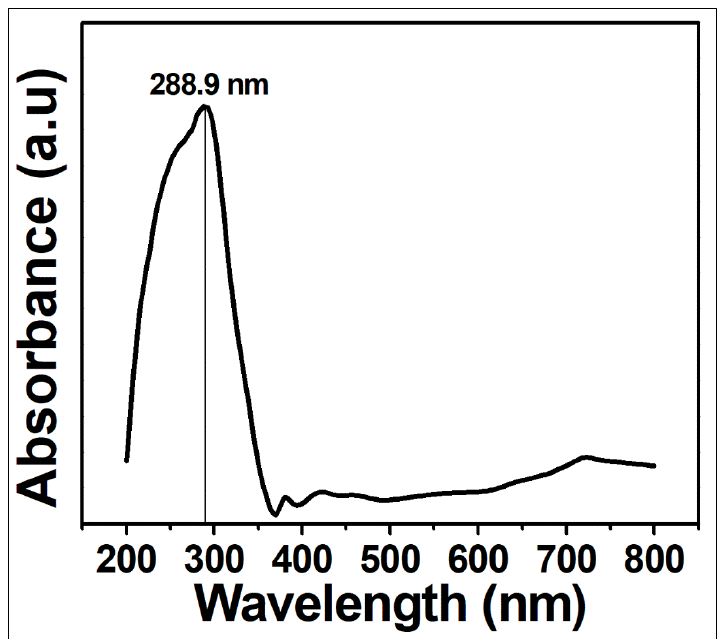
Figure 5. UV ‐ visible spectrum of biosynthesized Ni/NiO NPs using leaves extract of Gymnema sylvestre